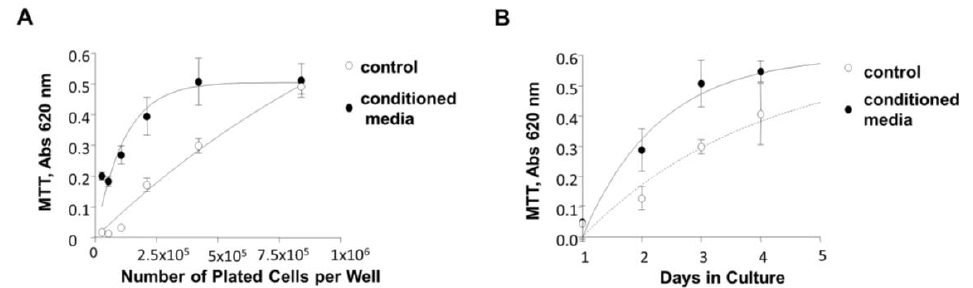
Figure 7. Cell culture medium conditioned with 84-31 mNIPP1 cells increases growth of 84-31 cells. ( A ) Media collected from 84-31-mNIPP1 cells were added to replace complete DMEM media from 84-31 cells. A different starting number of cells showed different rates of growth for 84-31 cells. To monitor cell proliferation, an MTT assay (Sigma-Aldrich) was used; ( B ). Plated 84-31 cells were grown for 4 days and compared with 84-31 cells treated with conditioned medium collected from 84-31-mNIPP1 cells. Cell proliferation was measured at 620 nm using the MTT assay kit. Assays were conducted in 96-well plates and done in triplicates. Cell number and vitality were determined by trypan blue staining using Cellometer (Nexcelom Bioscience, Lawrence, MA, USA). Means ± SD are shown ( n =